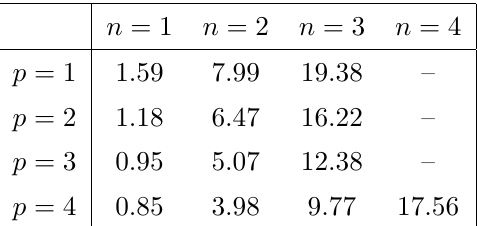
( p ) . No value denotes that U